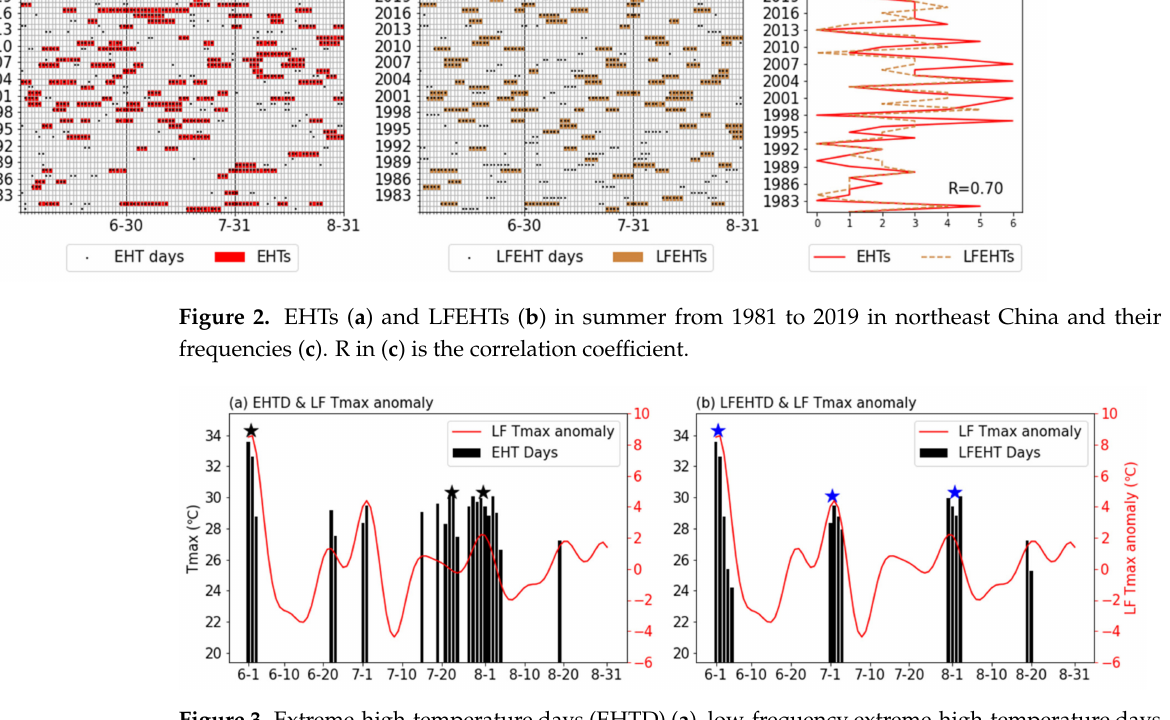
Figure 3. Extreme-high-temperature days (EHTD) ( a ), low-frequency extreme-high-temperature days (LFEHTD) ( b ), and daily low-frequency (10–30 d oscillation component) Tmax anomaly amplified 2 times during June to August in 2018 in Northeast China. Black and blue stars denote EHTs and LFEHTs,